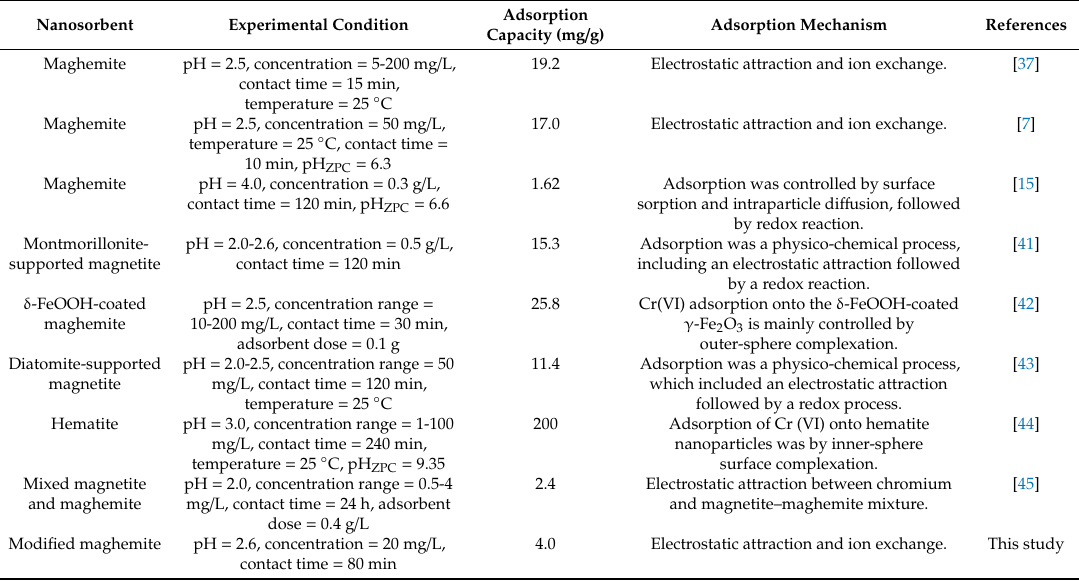
Table 5. Adsorption capacities and mechanisms of chromium (VI) removal by different iron-oxide-based